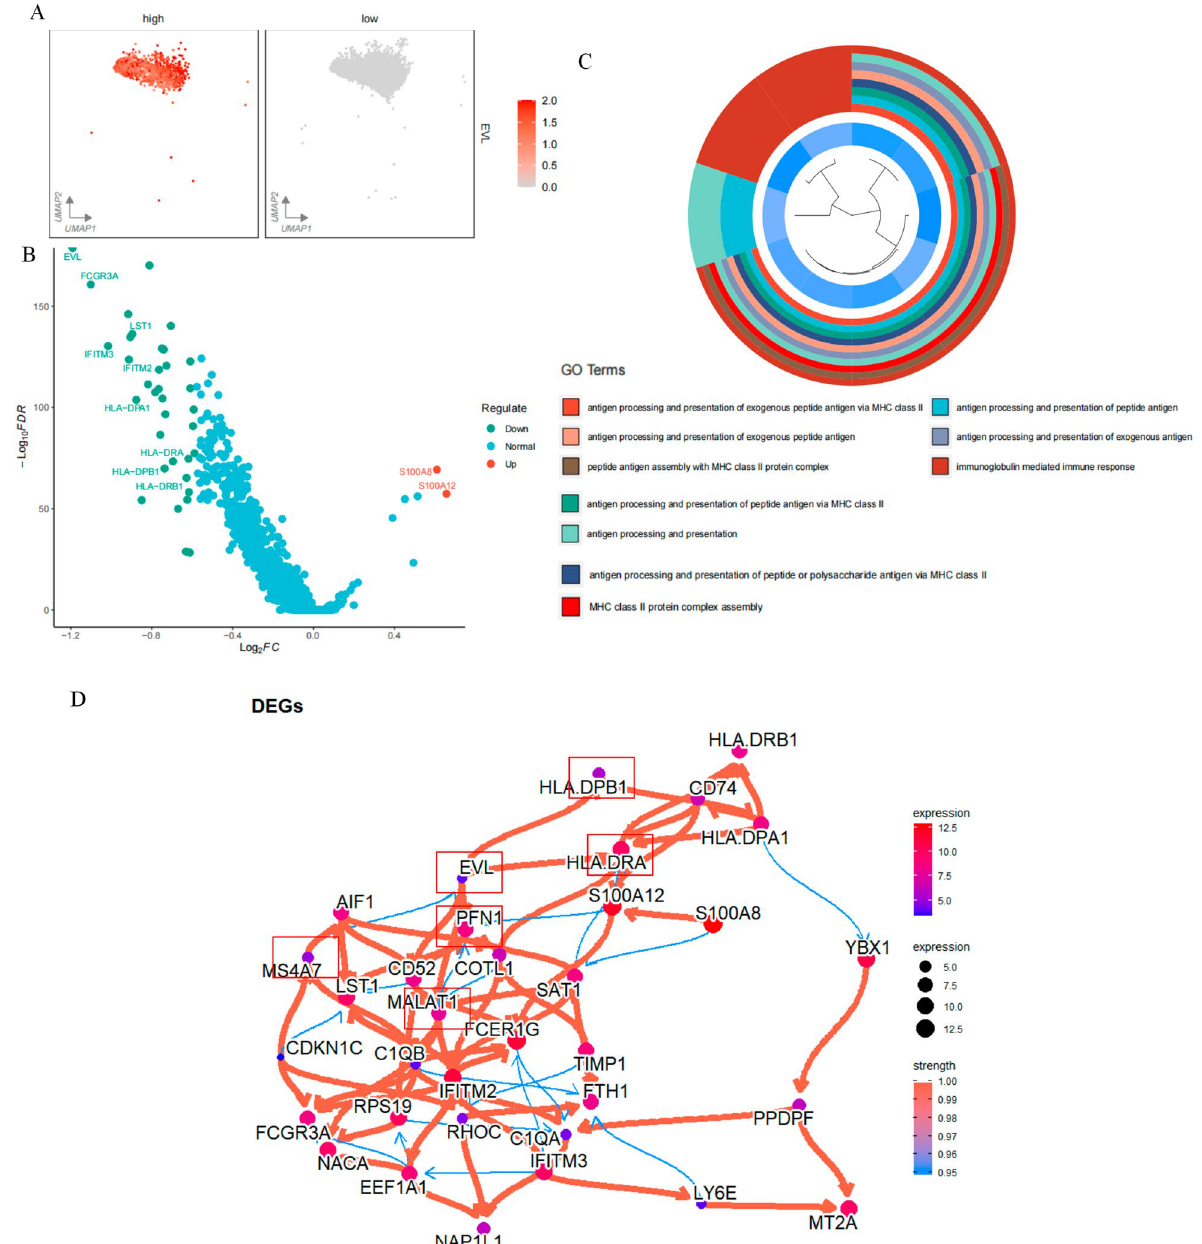
Fig. 6 Analysis of the gene regulatory network of EVL . A EVL was divided into high and low expression groups by the presence or absence of EVL expression. The color changes from gray to red representing increasing gene expression; B Differential analysis of EVL low-expressing cells and EVL high-expressing cells. Green represents down-regulated genes, red represents up-regulated genes, and blue represents genes that did not change; C GO enrichment analysis. In the outermost circle, different colors represent different pathways. In the inner circle, each bar represents a gene, and the bluer the color, the lower the expression value of that gene; D Bayesian network to infer the gene regulatory network of EVL. Each node represents a gene, the redder the node color, the larger the node means the higher the expression value of the gene. The thicker the line is, the greater the strength of the regulatory